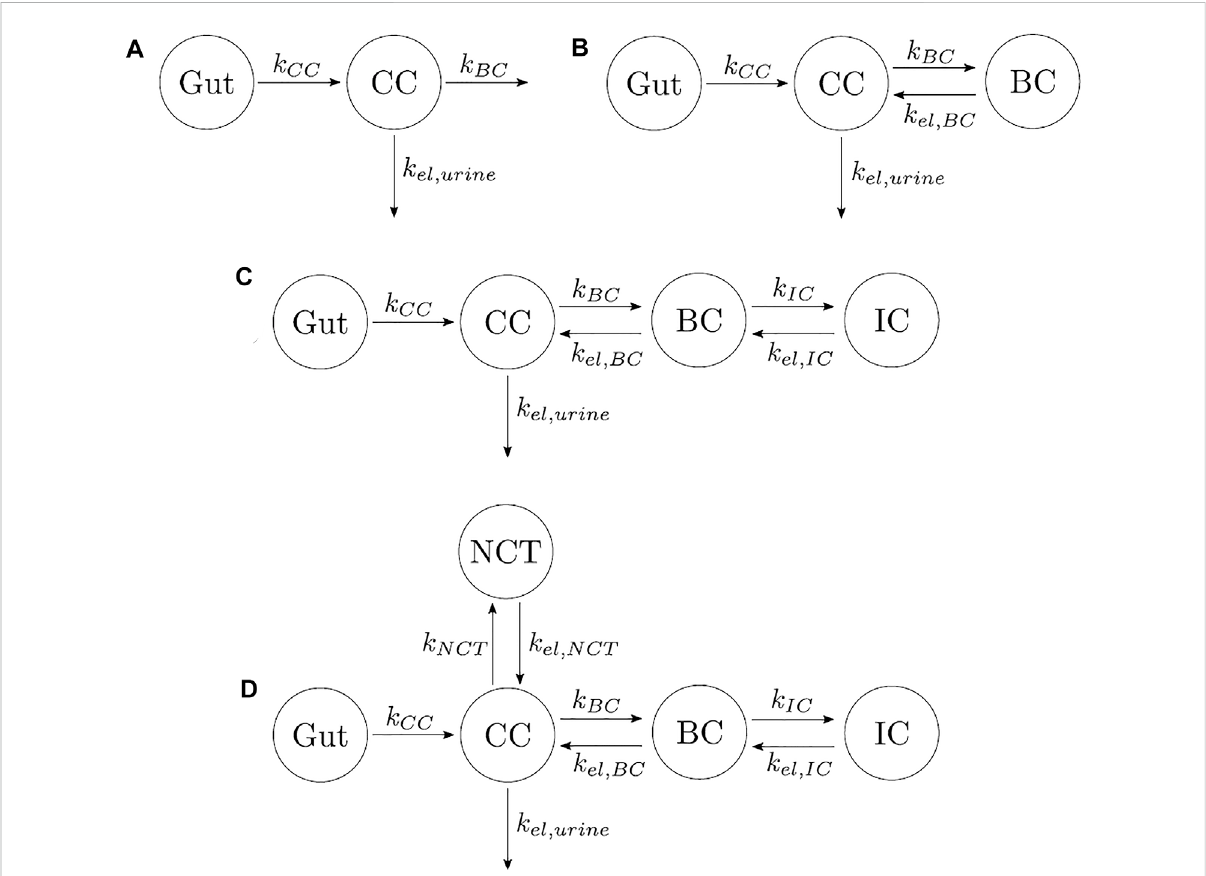
FIGURE 2 Different types of PK models for alendronate considering various numbers of compartments and different compartmental interactions. (A) One-compartment model with two elimination mechanisms. (B) Two-compartment model. (C) Three-compartment model “ in series. ” (D) Four- compartment